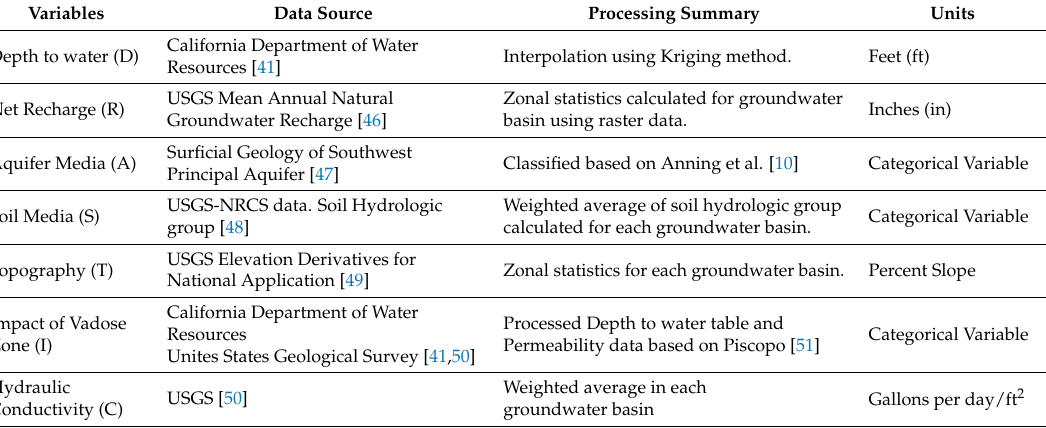
Table 1. Optimized-DRASTIC variable